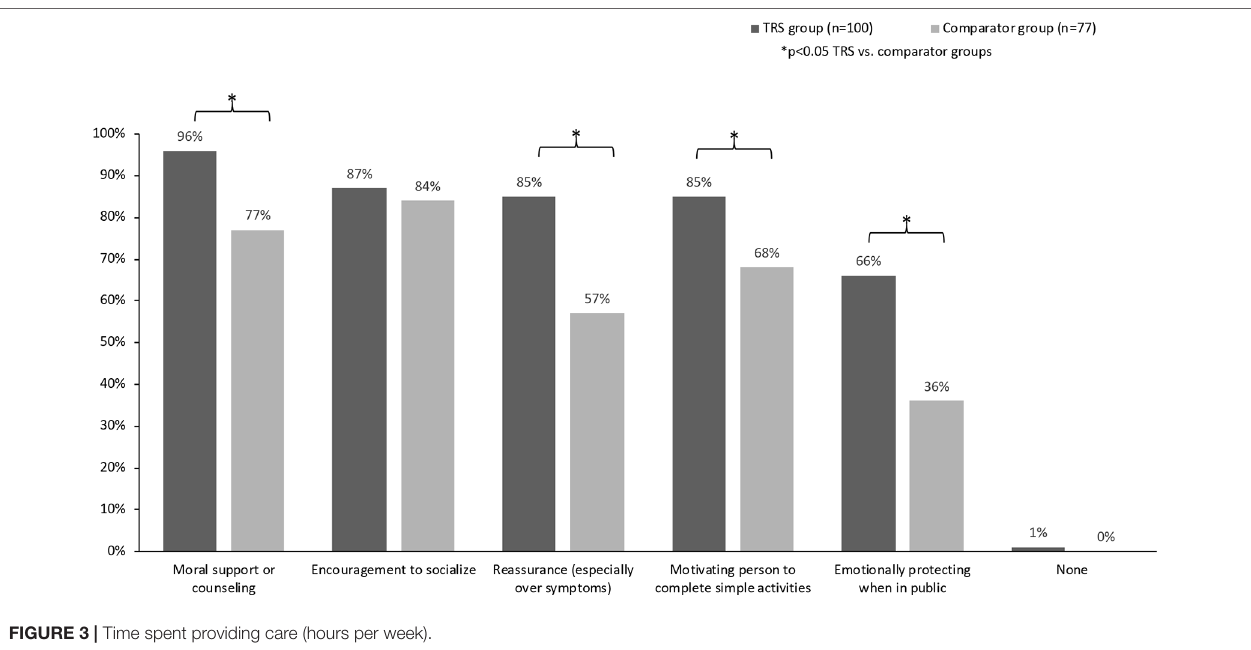
FIGURE 3 | Time spent providing care (hours per week).